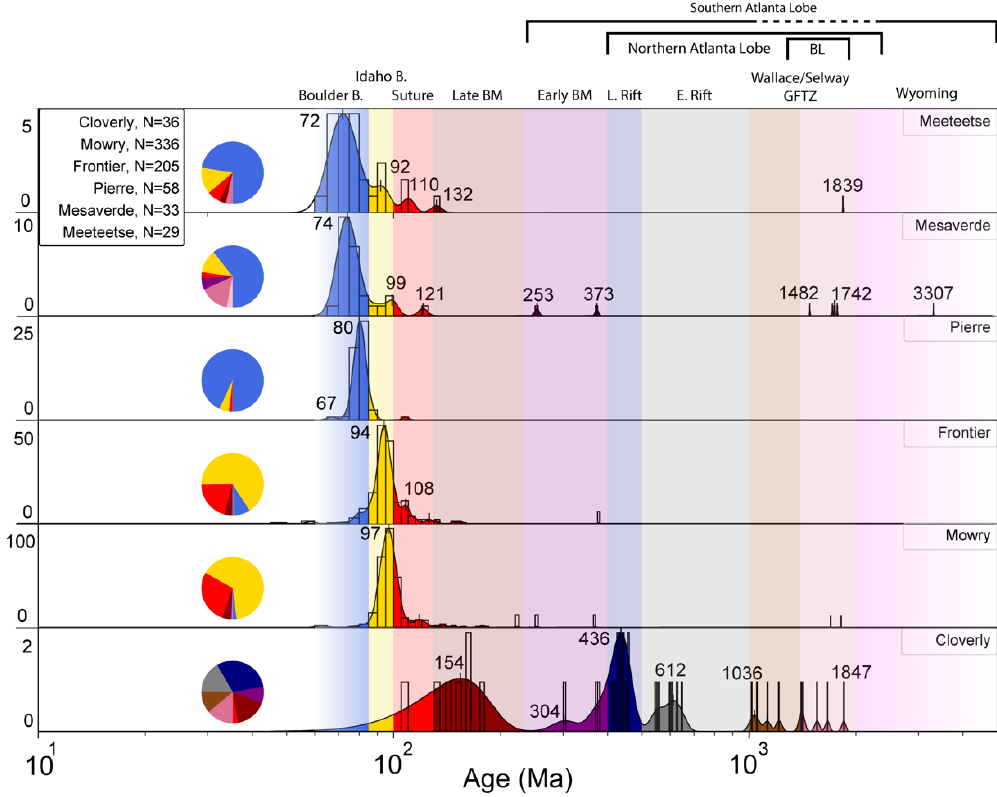
Figure 5. Tephragenic zircon age-probability distributions (also shown in pie charts) grouped by sampled formations from the Bighorn Basin, WY and the Angostura Reservoir, Pierre, SD. Ages are based on best age using 206 Pb/ 238 U on grains younger than 1.1 Ga and 206 Pb/ 207 Pb for grains older than 1.1 Ga. Ages are given for prominent peaks in the distributions. The plot has been separated into bins, selected based on probable inheritance. Bins are divided as 60–85 Ma (Montana volcanism [31]), 85–100 Ma (Idaho volcanism [46]), 100–130 Ma (Salmon River Suture Zone [47]), 130–250 Ma (Late Blue Mountain arcs [48]), 250–400 Ma (Early Blue Mountain arcs, Baker terrane [49]), 400–500 Ma (Late Rodinia extension), 500–1000 Ma (Early Rodinia extension, [50]), 1.0–1.4 Ga (Belt Supergroup [13]), 1.4–2.0 Ga (Early Wallace/Selway basement [51]) and 2.0–3.6 Ga (Wyoming basement [52]). Pie diagrams show the abundance of grains from each bin. Example inheritance data (bottom left) from the Idaho batholith [46]. Plot and age peaks generated using detritalPy for Python 3.x [56].